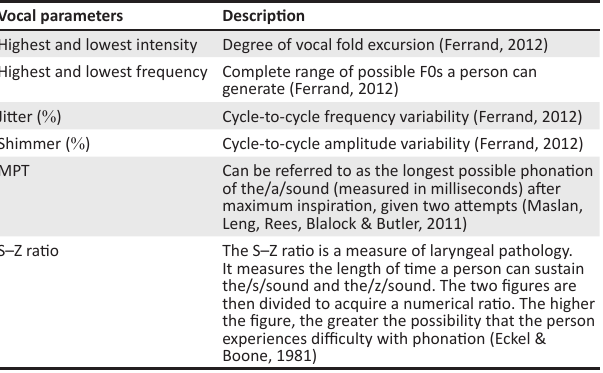
TABLE 1: Description of acoustic parameters. Vocal